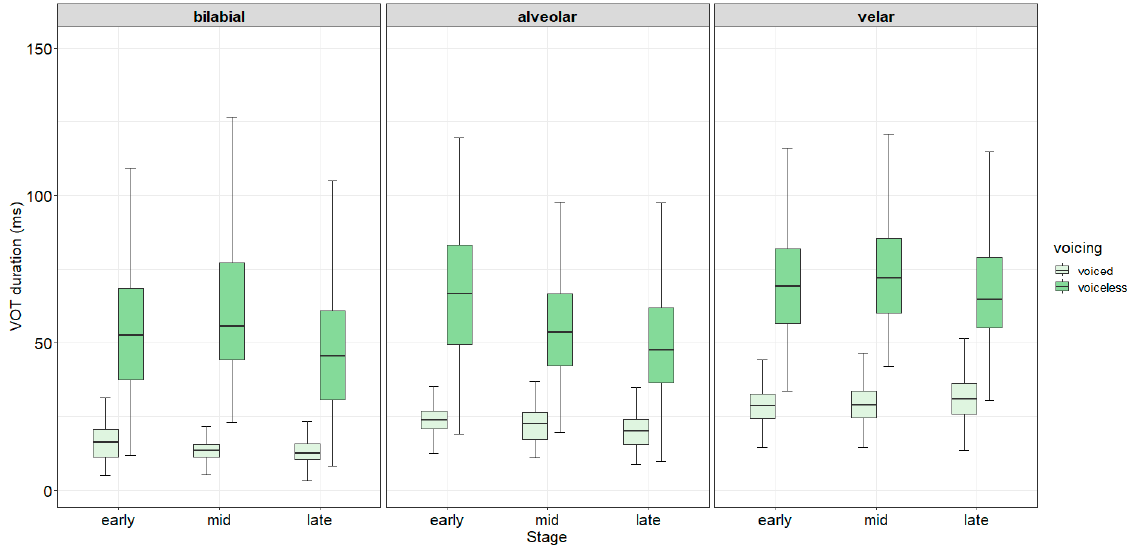
Figure 2. VOT durations (in ms) of AS’s English plosives.